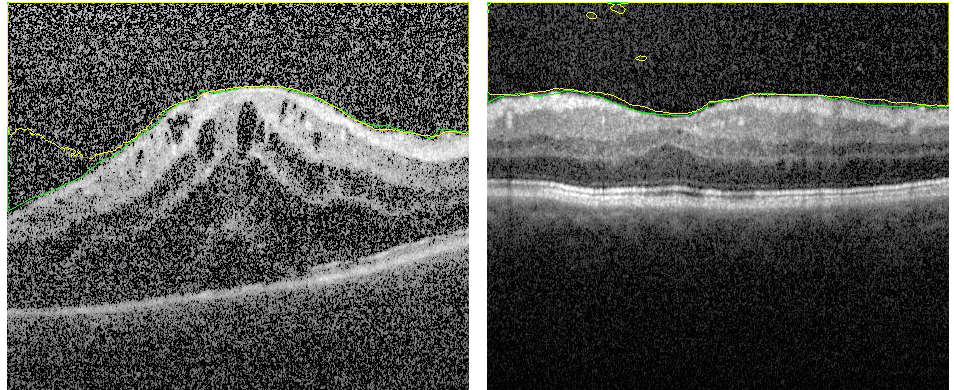
Figure 8. Segmentation sample when distance map is removed from fused images. Number of training epochs is limited. There are some artifacts which are removed when using the FI as